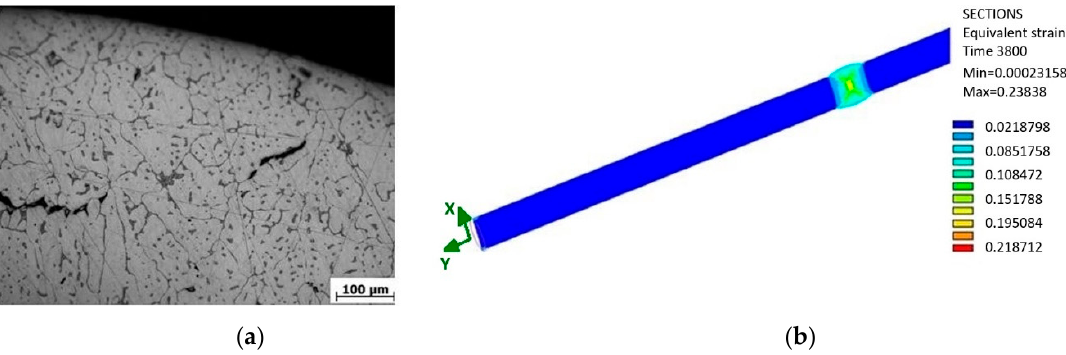
Figure 22. ( a ) The microstructure of the welded joint of the sample in the cross-section with the application of the filler material AlSi 5 , etched by HF 0.5% and ( b ) the strain state in the specimen during twisting stress.